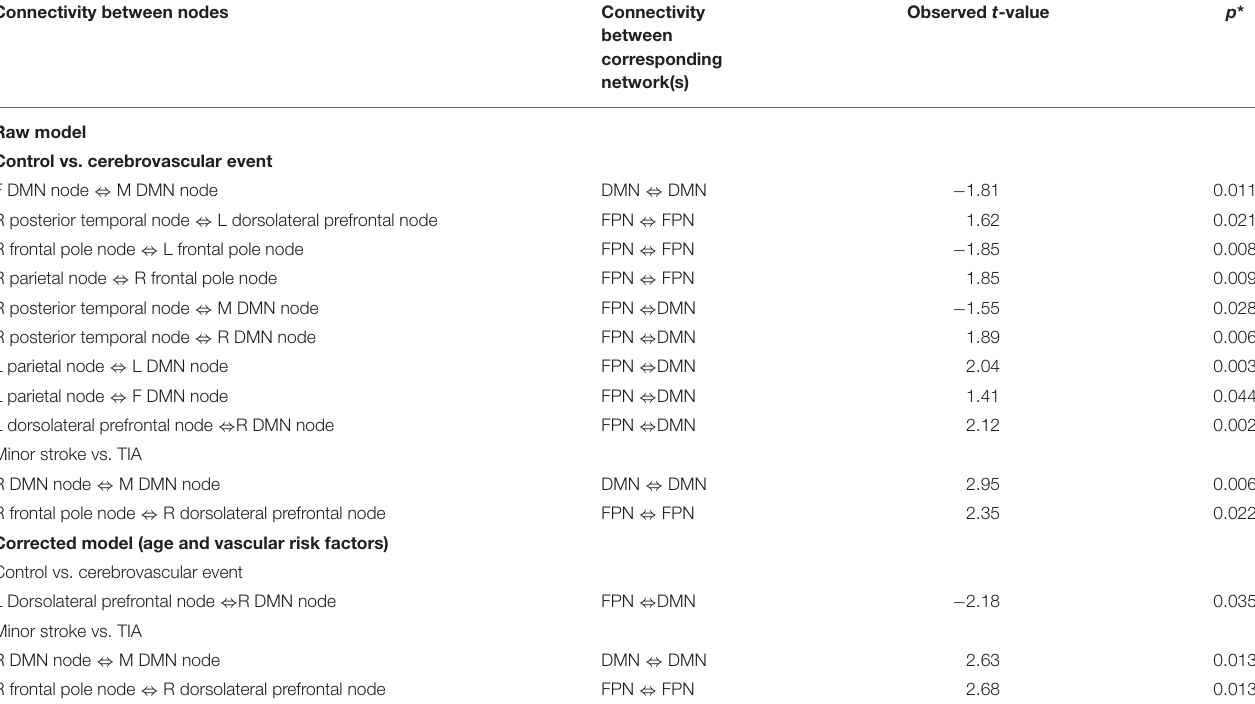
TABLE 4 | Significant groups differences in the strength of rsFC between nodes extracted from the DMN and the FPN network. Connectivity between nodes Connectivity